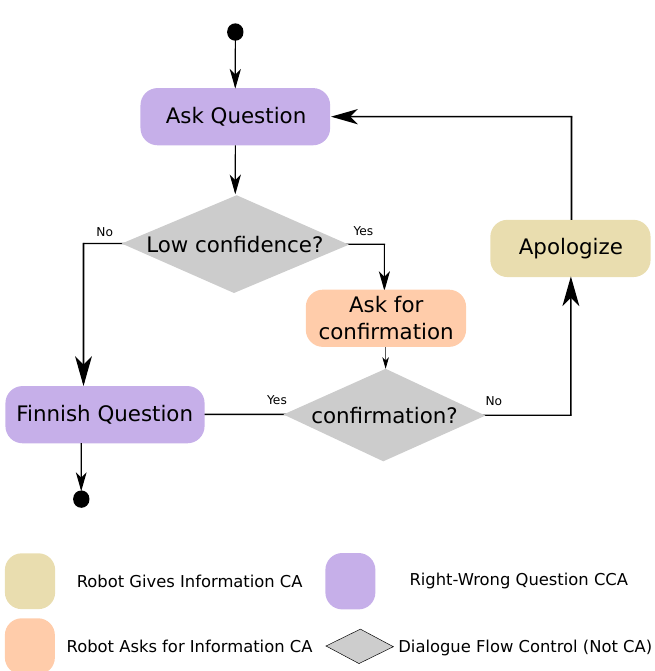
Figure 4. Flow diagram for the question with confirmation CCA. This CCA asks the user for an explicit confirmation of the answer if the confidence of the answer recognition is below a given